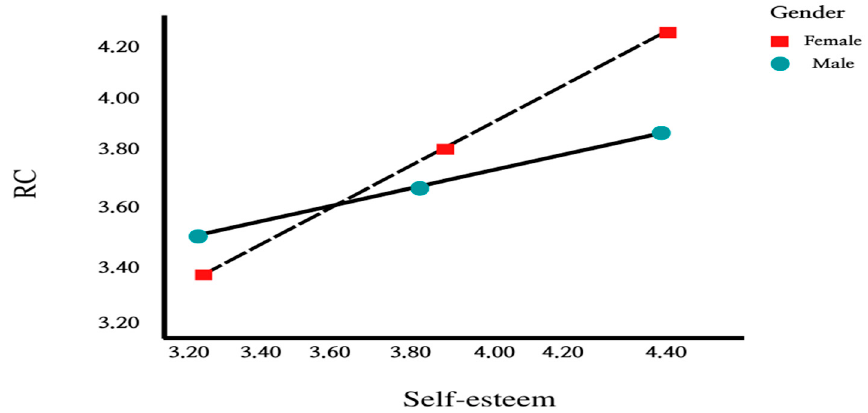
Figure 3. Moderated mediation effect of self-esteem.